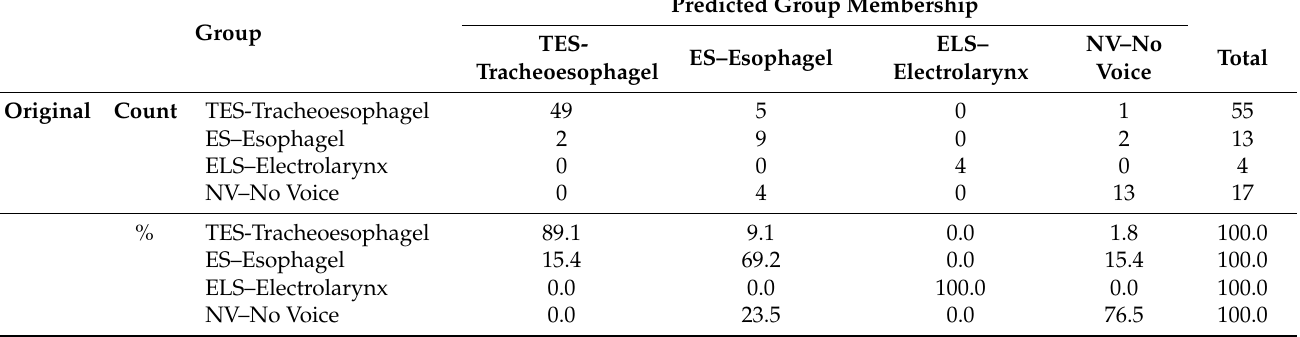
Table 4. Classification results.